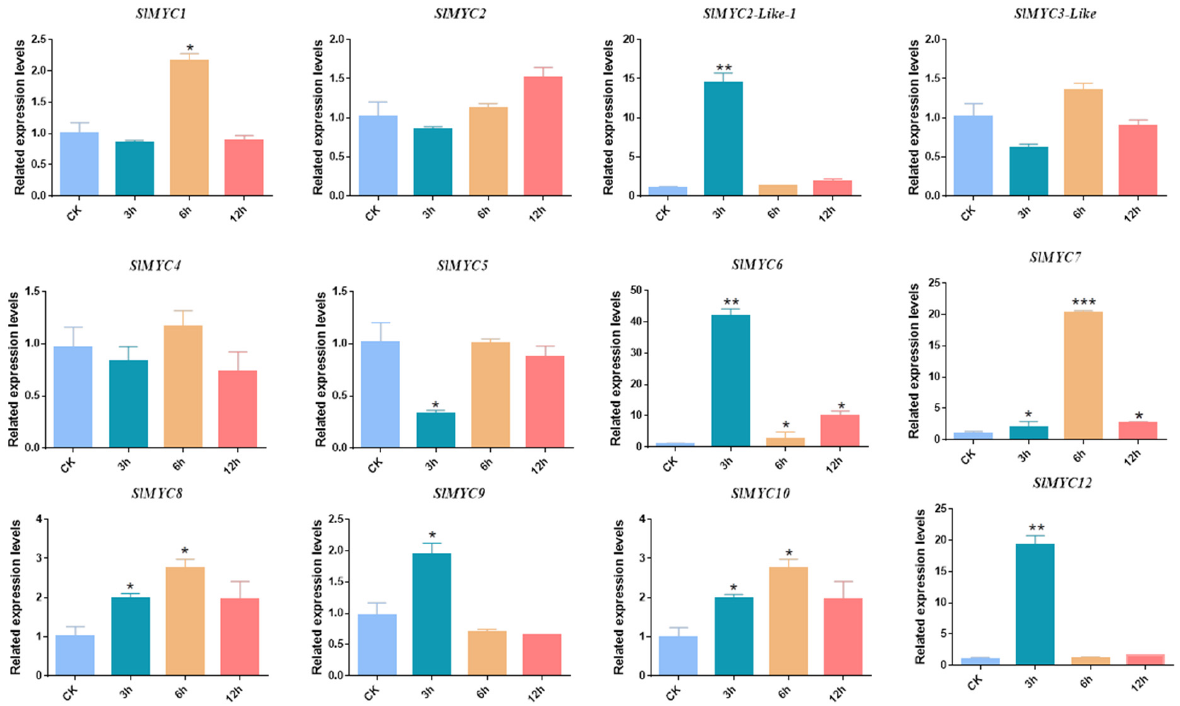
Figure 6. Response analysis of SlMYC genes in leaves under MeJA treatment by qRT-PCR. The expression patterns of SlMYC in response to 100 µM MeJA treatment for 3 h, 6 h, 12 h. Data represent the means of three biological replicates ±SD. Different colors were used to indicate different treatment times ( p -values less than 0.05 are summarized with one asterisk, p -values less than 0.01 are summarized with two asterisks and p -values less than 0.0003 are summarized with three asterisk).